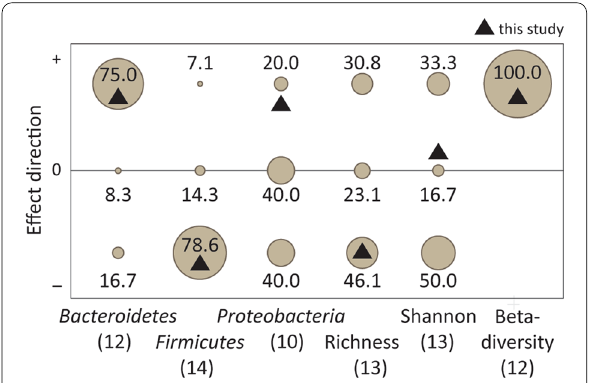
Fig. 8 The effect directions of temperature on some aspects of vertebrate gut bacterial community found in 18 studies and 17 species. Literature sources and data, including some additional data, are presented in Additional file 1: Table S3. A positive effect direction ( ) indicates an increase with temperature or a significant difference + in beta-diversity, a negative effect direction ( ) indicates a decrease − with temperature (does not apply to beta-diversity), and the 0 indicates no significant effect. Circle size represents the percentage of studies with that effect direction within the studies that reported on the concerned index; this percentage is specified by the numbers near the circles. The number of studies that presented data for the given taxa, alpha- and beta-diversity indices are indicated between brackets under the X-axe